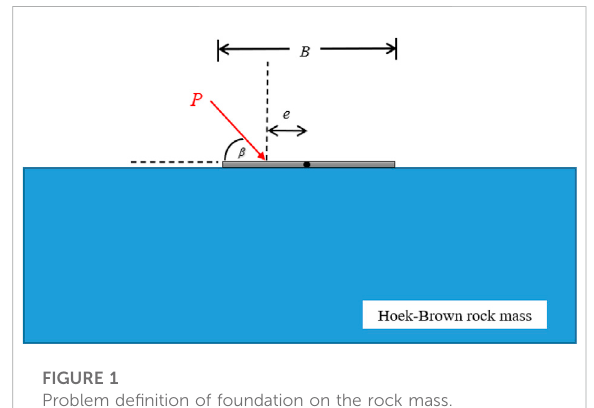
FIGURE 1 Problem de fi nition of foundation on the rock